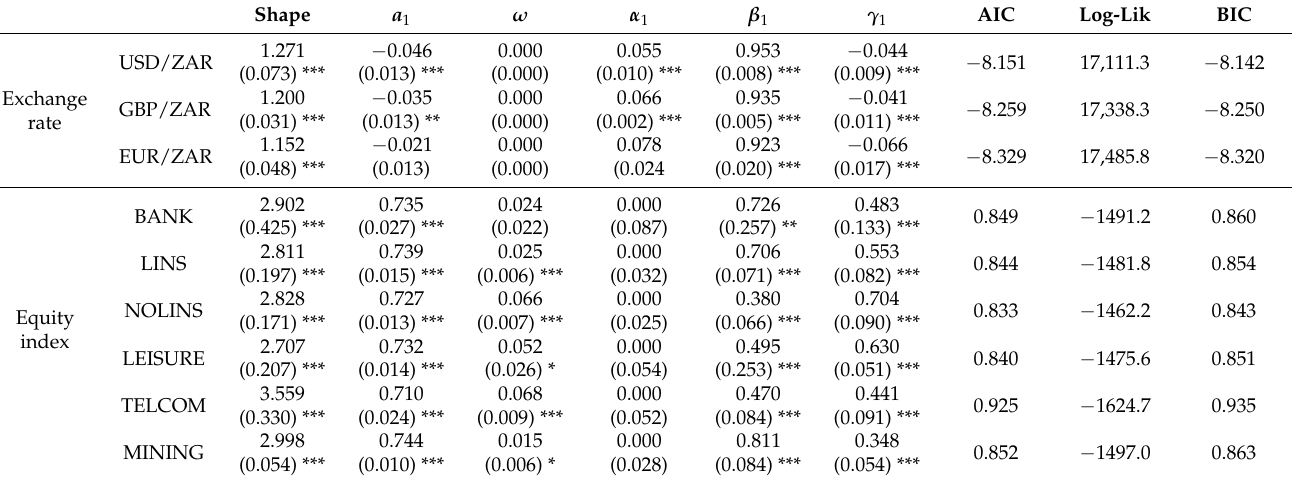
Table 1. Parameter estimates for marginal models using GJR-GARCH